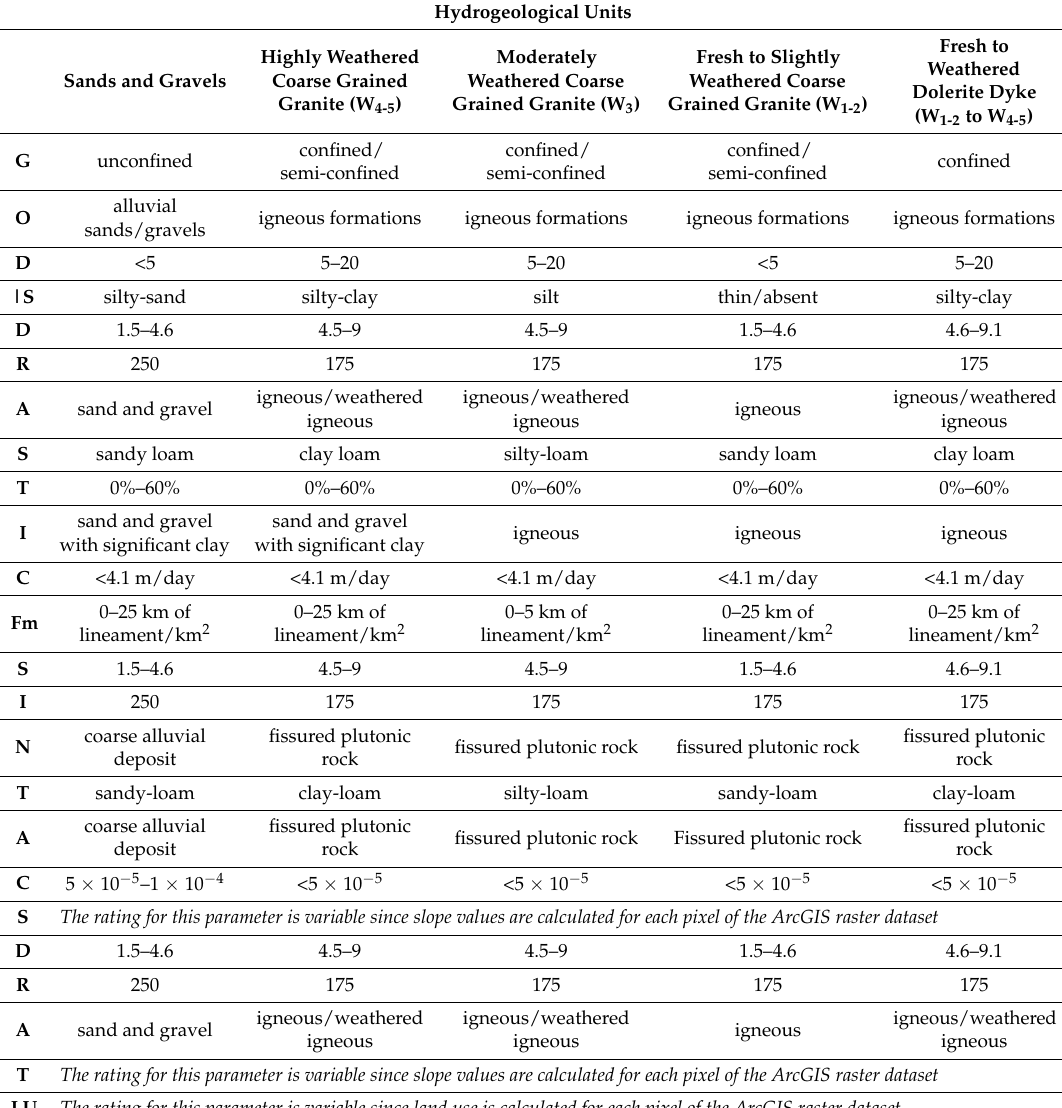
Table 1. GOD-S, DRASTIC-Fm, SINTACS and SI (DRAT-LU) parameters used in the surrounding area of the Caldas da Cavaca site, adapted from